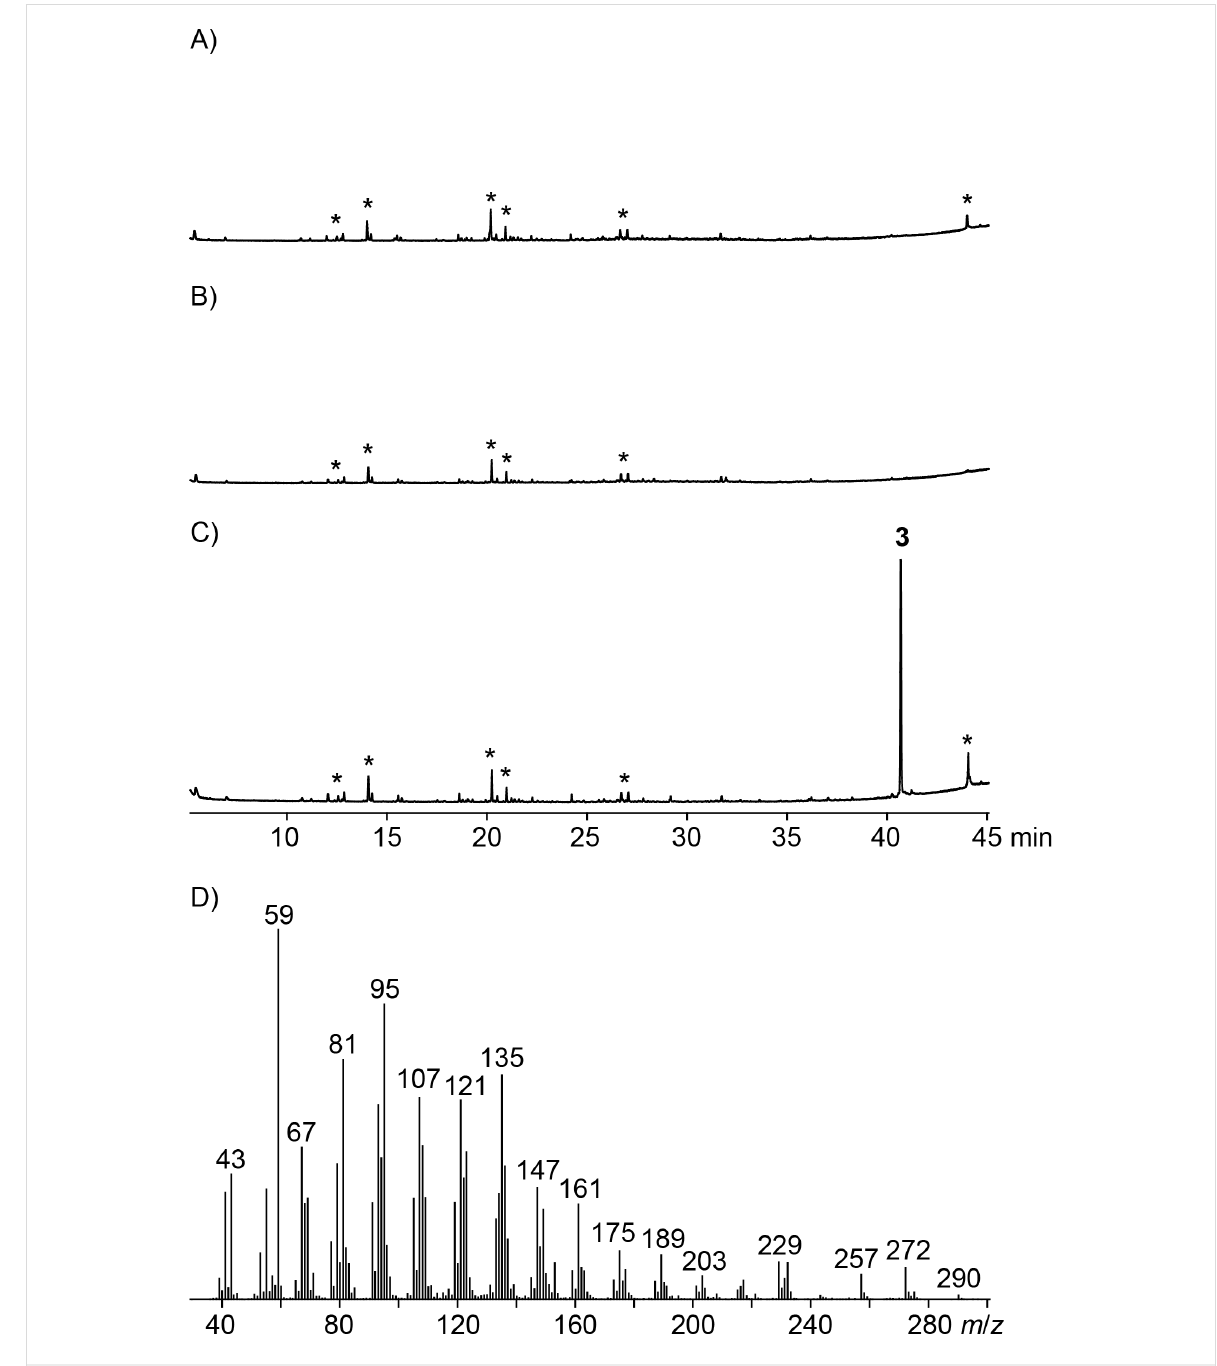
Figure 1: In vitro terpene synthase activity of the investigated recombinant enzyme from C. pinensis , showing no formation of monoterpenes from GPP (A) and no formation of sesquiterpenes from FPP (B), but formation of a single diterpene alcohol 3 from GGPP (C) with the mass spectrum depicted in (D). Asterisks indicate non-terpenoid contaminants such as plasticisers.